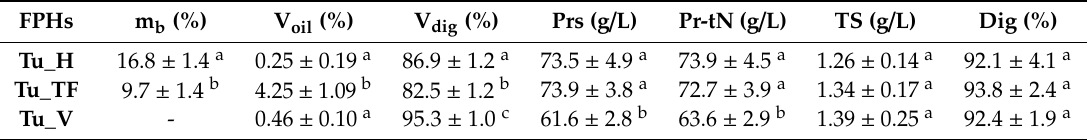
Table 2. Mass balances and proximal analysis of the products obtained from Alcalase hydrolysates of turbot by-products.